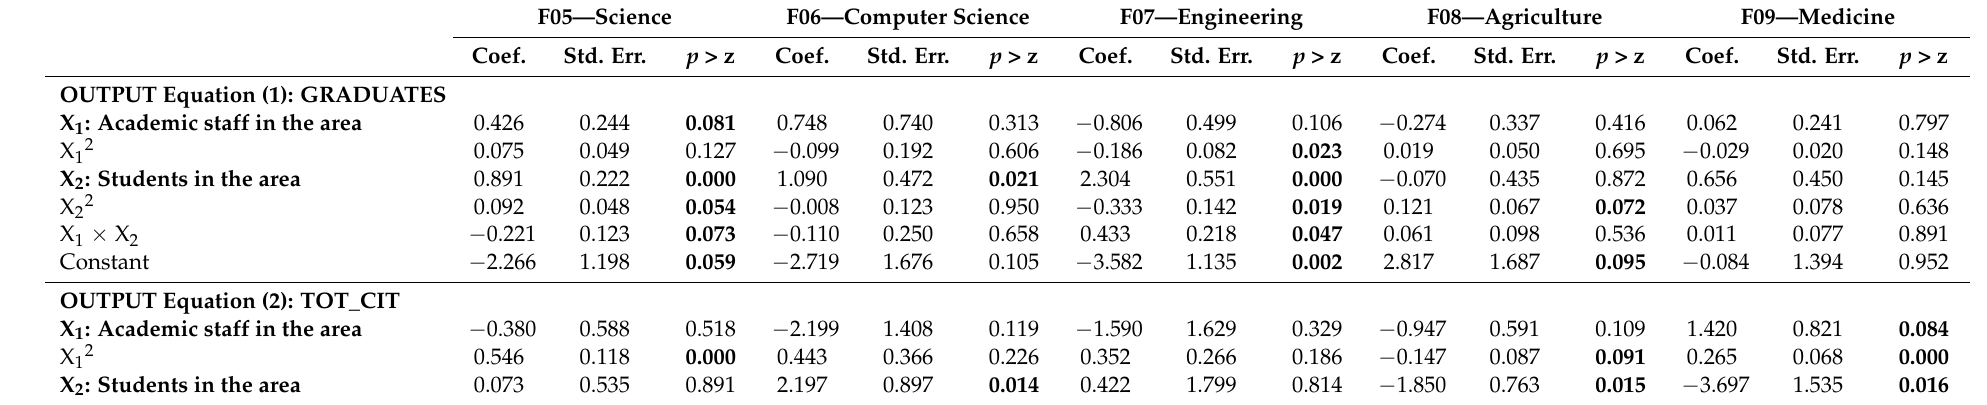
Table 4. SUR Estimates: reduced Translog